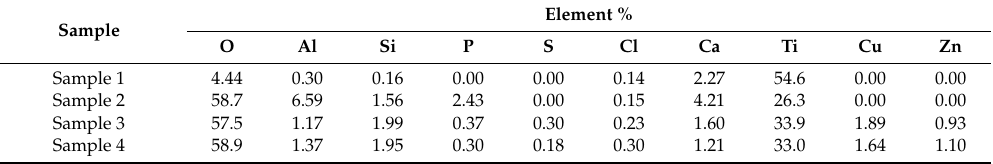
Figure 13. Relative composition of the atomic elements determined through EDS for the implanted materials: ( a ) Samples 1, ( b ) 2, ( c ) 3, and ( d ) 4. Table 3. Elemental EDS composition in mass percentages (%) for the studied